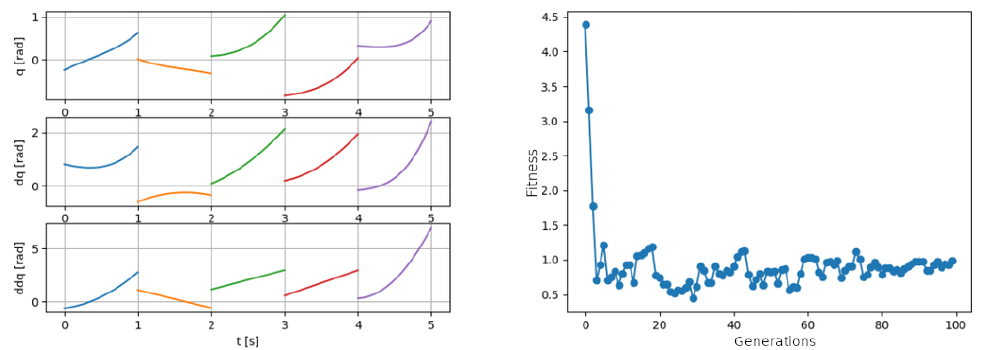
Figure 11. The achieved results for the GA with 100 candidate solutions trained for 100 generations. The best-achieved solution is visualized on the ( left ), and the fitness change through generations is on the ( right